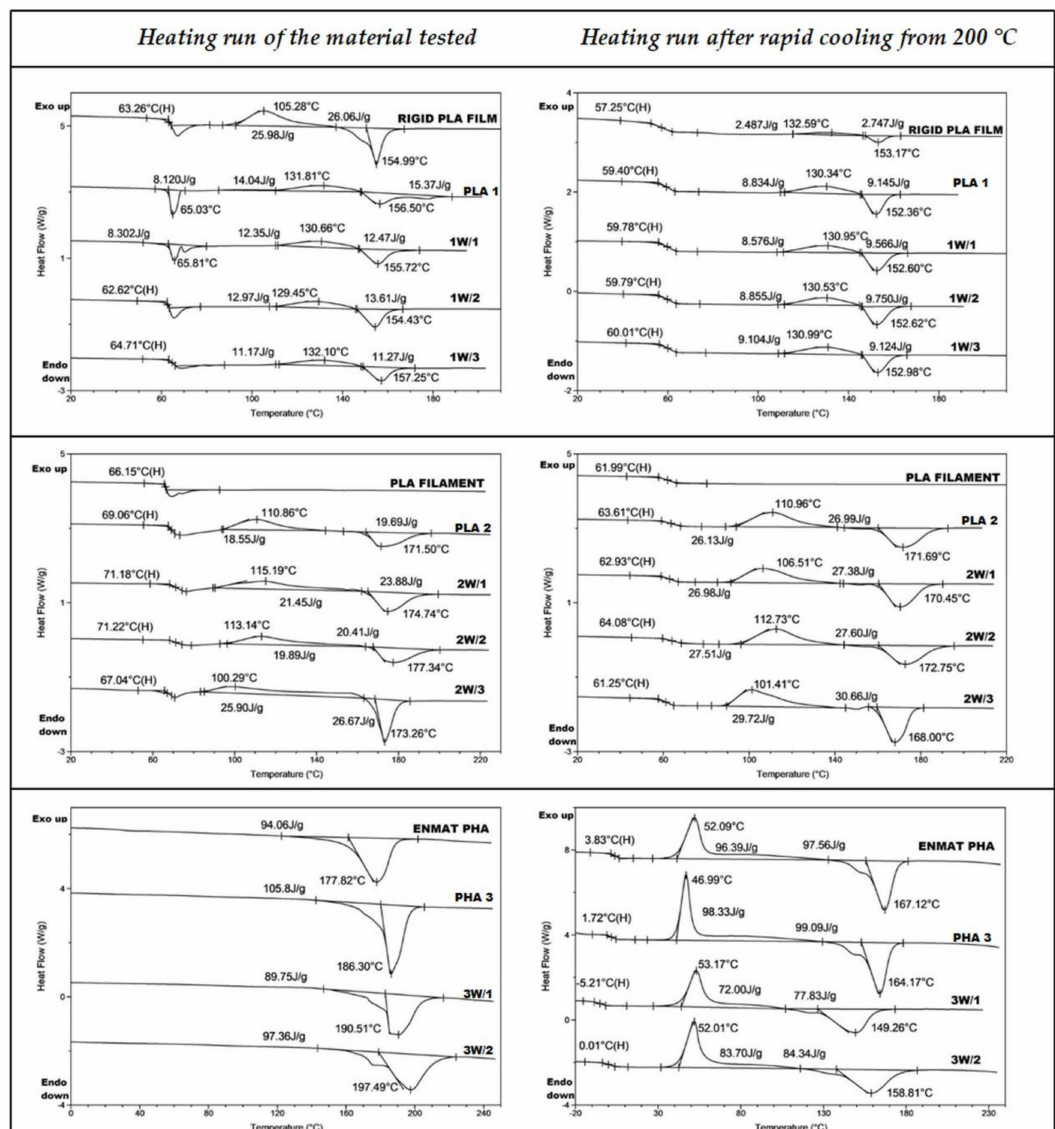
Figure 3. DSC traces of the samples